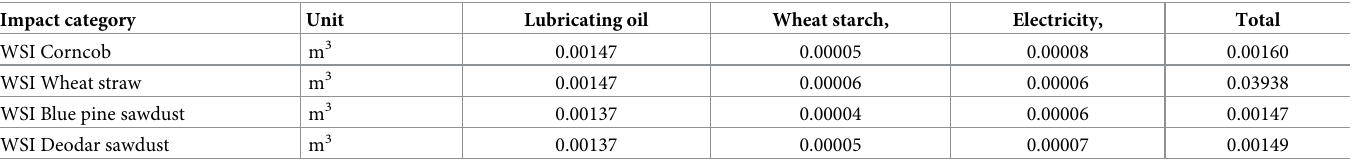
Table 5. Water footprint of biomass pellets from various agro-forest species